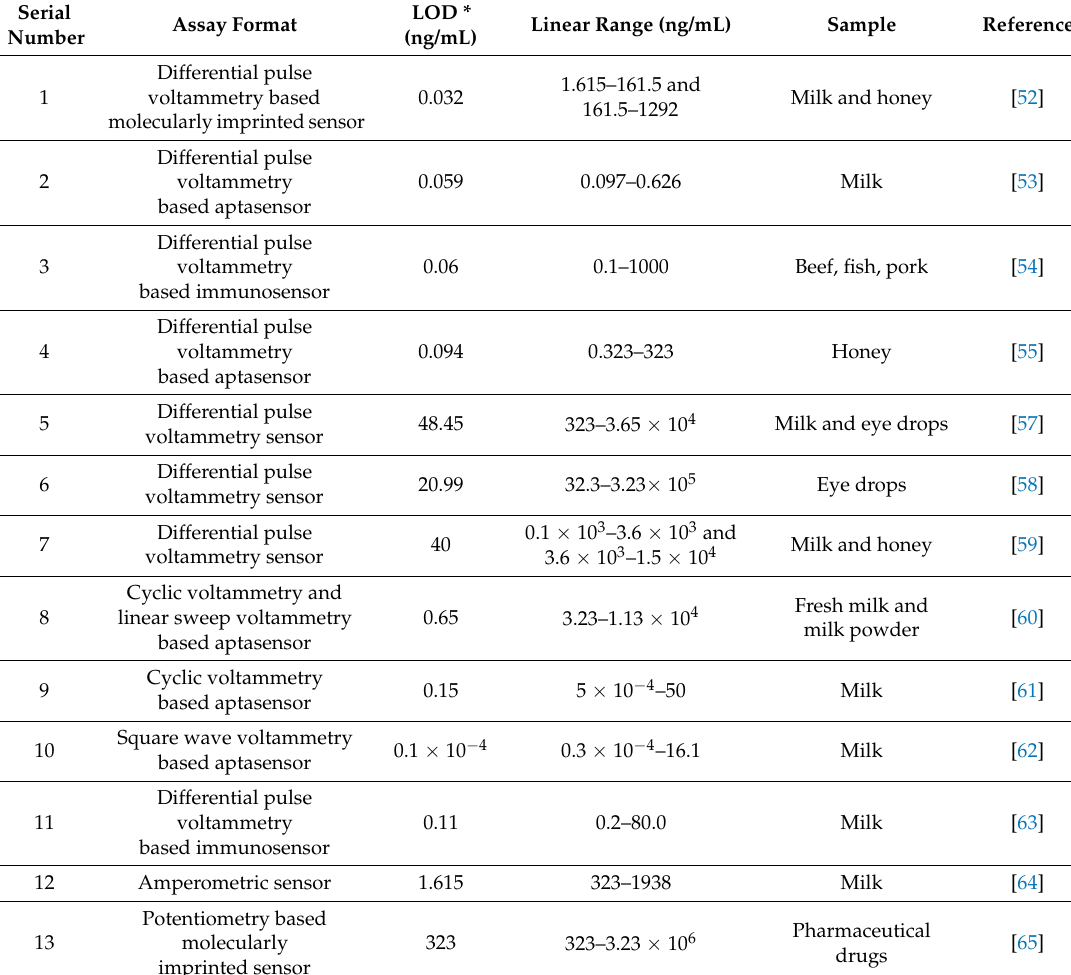
Table 2. Summary of reported studies on electrochemical biosensors for the detection of